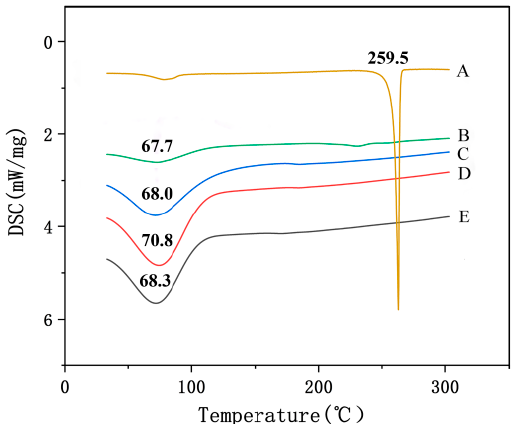
Figure 5. DSC thermograms of nanofibers and raw materials. A: emodin; B: CA; C: PVP; D: nanofibers without emodin; E: nanofibers with emodin.